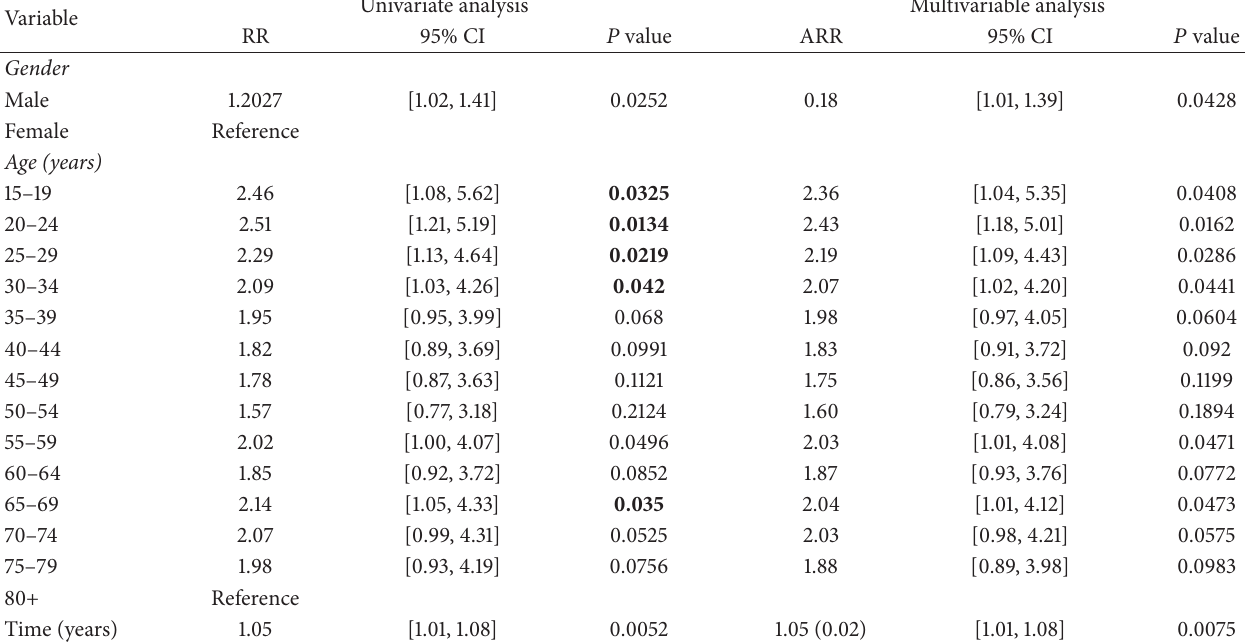
Table 4: Crude and adjusted relative risk of colon cancer among CRC